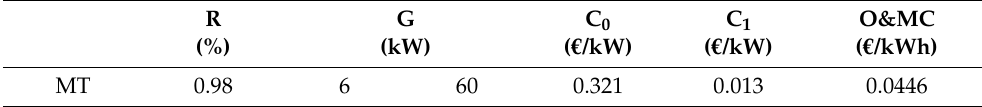
Table 5. Power limits and cost coefficients of micro turbine